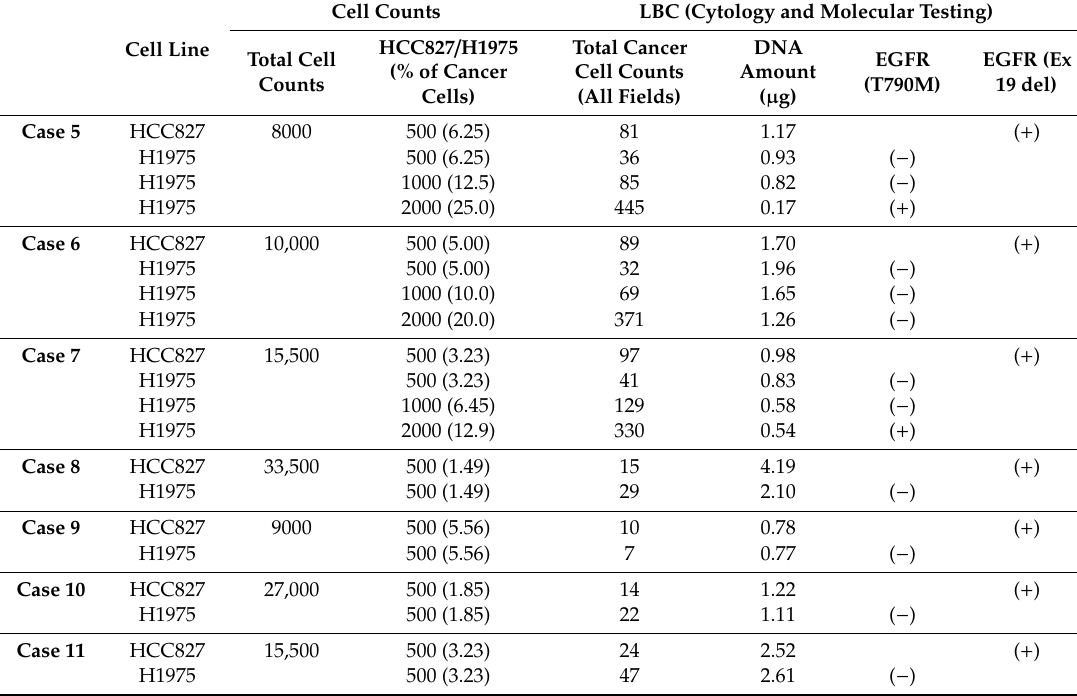
Table 3. Cell counts and EGFR mutation detection in the sputum